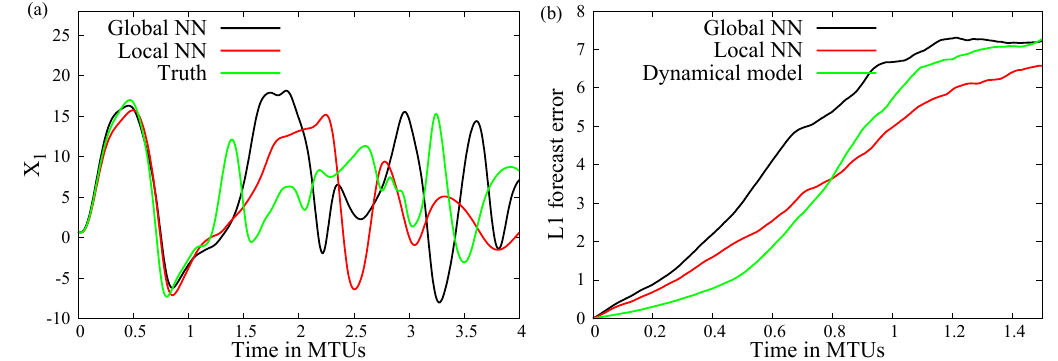
Figure 1. (a) Example trajectory for the global and local NN as well as the truth. (b) L1 error for forecasts with the global and local NN as well as the truncated dynamical forecast